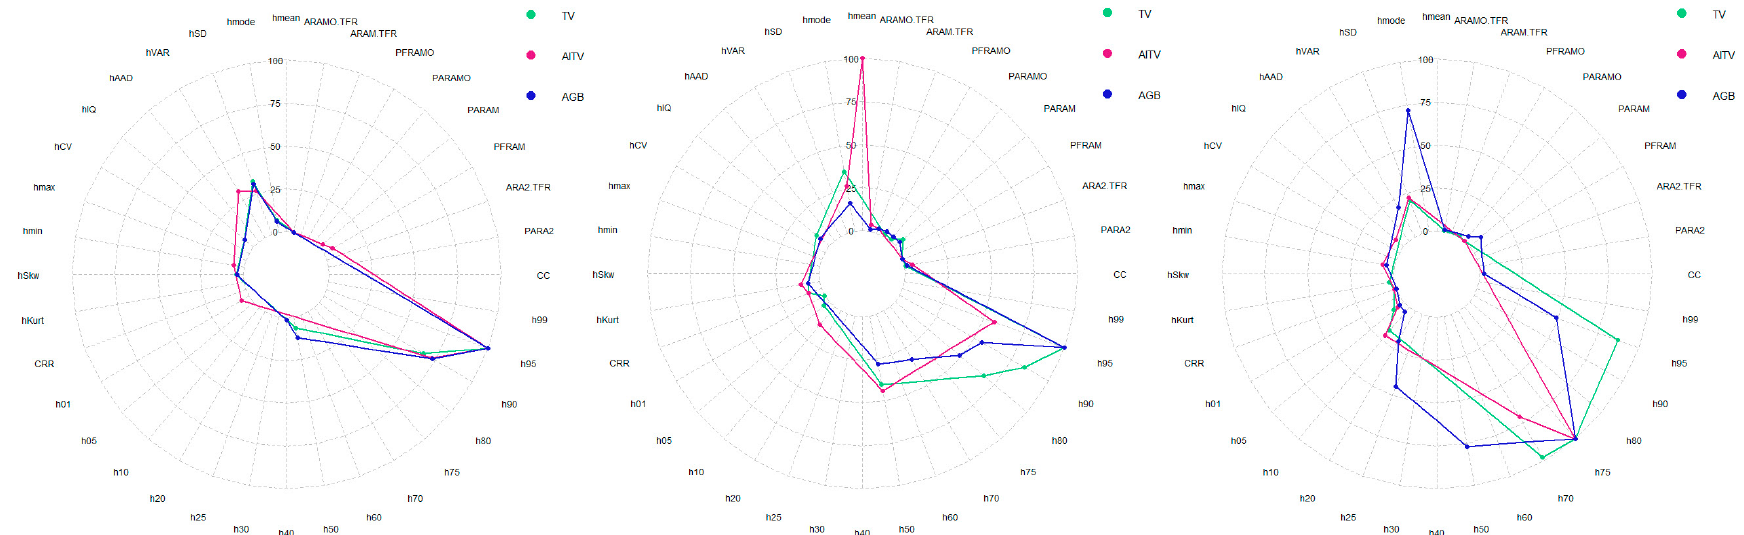
Figure 2. Variables included in the models (VIM), for the best techniques, including type and variable importance for E. globulus (column 1), P. pinaster (column 2) and P. radiata (column 3). To ensure that values of variable importance are expressed on comparable scales for each of the response variable, the scores of all the predictors selected were normalized so that they added up to a unitary value (normalized importance), or they were expressed as relative values: Relative importance = (VIM-VIMmin)/(VIMmax-VIMmin).